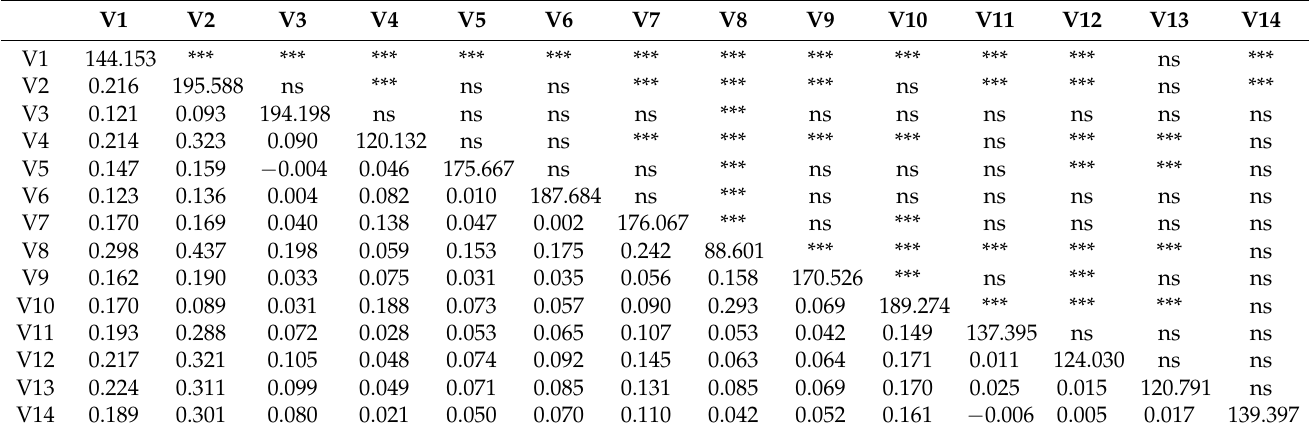
Table 5. Population pairwise F ST calculated considering sampling stations in the Volturno river, calculated in Arlequin. On diagonal: average number of pairwise difference within population. Above the diagonal: the p-value significance after Bonferroni correction. Sample locations and codes are detailed in Table